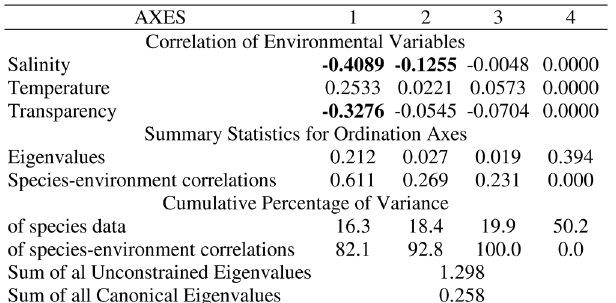
Table 5. Summary of the CCA performed on the abundance of juveniles species of Engraulidae family. Significant envi - ronmental variables were selected by a stepwise procedure analogous to forward elimination in multiple regression analysis. Significant values (p < 0.05) in